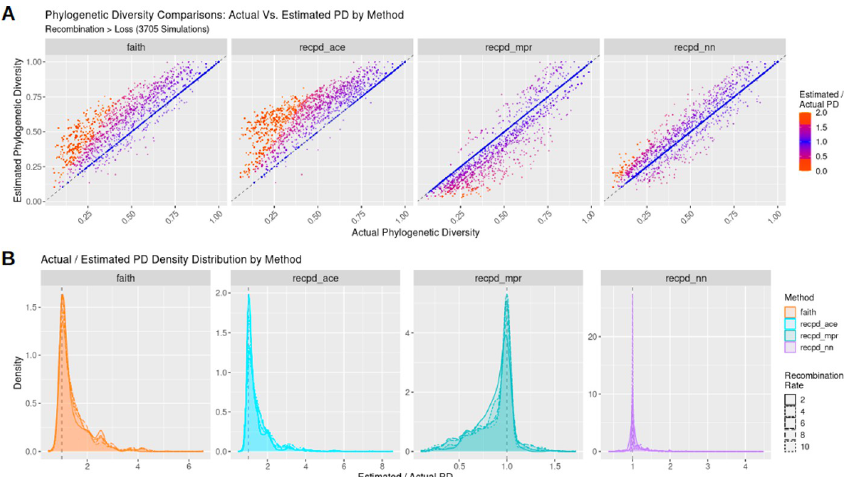
Fig 3. RecPD with nearest-neighbours (NN) ancestral state reconstruction accurately identifies simulated gene family evolutionary histories, while MPR and ACE over- and under- estimate recombination, respectively. Summary of simulations of gene family evolution comparing actual phylogenetic diversity to estimated diversity using Faith’s PD and RecPD employing three different ancestral reconstruction methods (NN, MPR, and ACE: see Table 1 for parameters used and number of simulations run). (A) Scatterplots of estimated PD values against actual PD values by method. (B) Corresponding density plot distributions. Results are shown for recombination predominant rate regime on randomly generated trees with 10 tips.